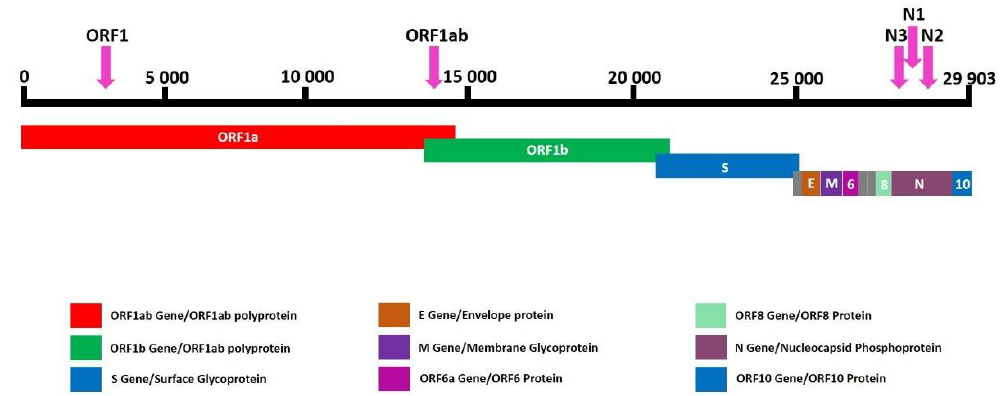
Figure 1. SARS-CoV-2 genome and approximate locations of targets in the MassARRAY SARS-CoV-2 panel. Table 1. Compositions of the reagent mixtures for all steps of the MassARRAY ® SARS-CoV-2 Panel.